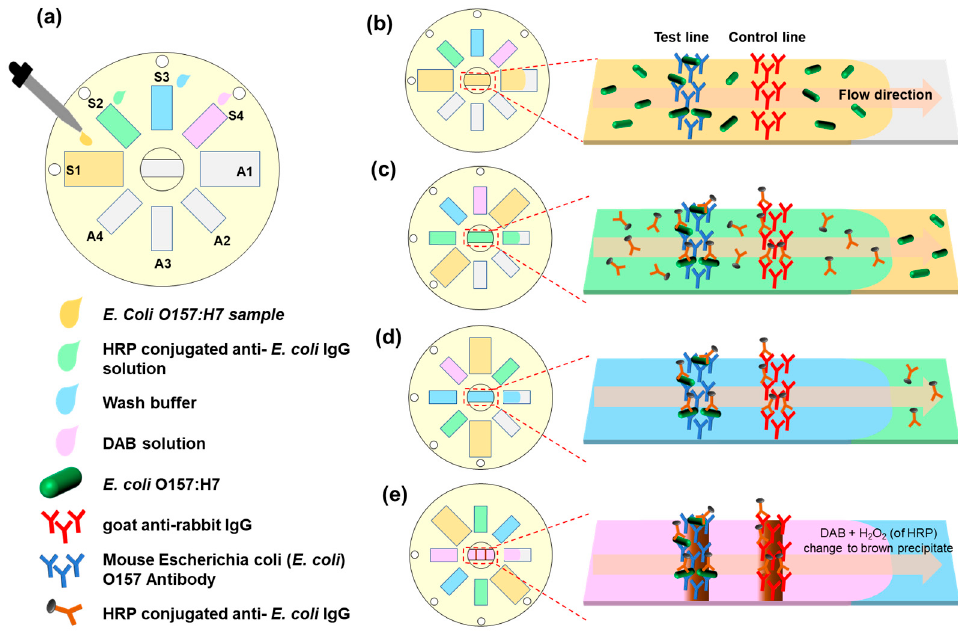
Figure 3. Schematics of each step of strip-based multistep immunoassay showing ( a ) loading the reagent for assay on the rotary pad, ( b ) bacteria capture, ( c ) HRP-IgG labeling, ( d ) wash, and ( e ) signal generation using DAB steps.